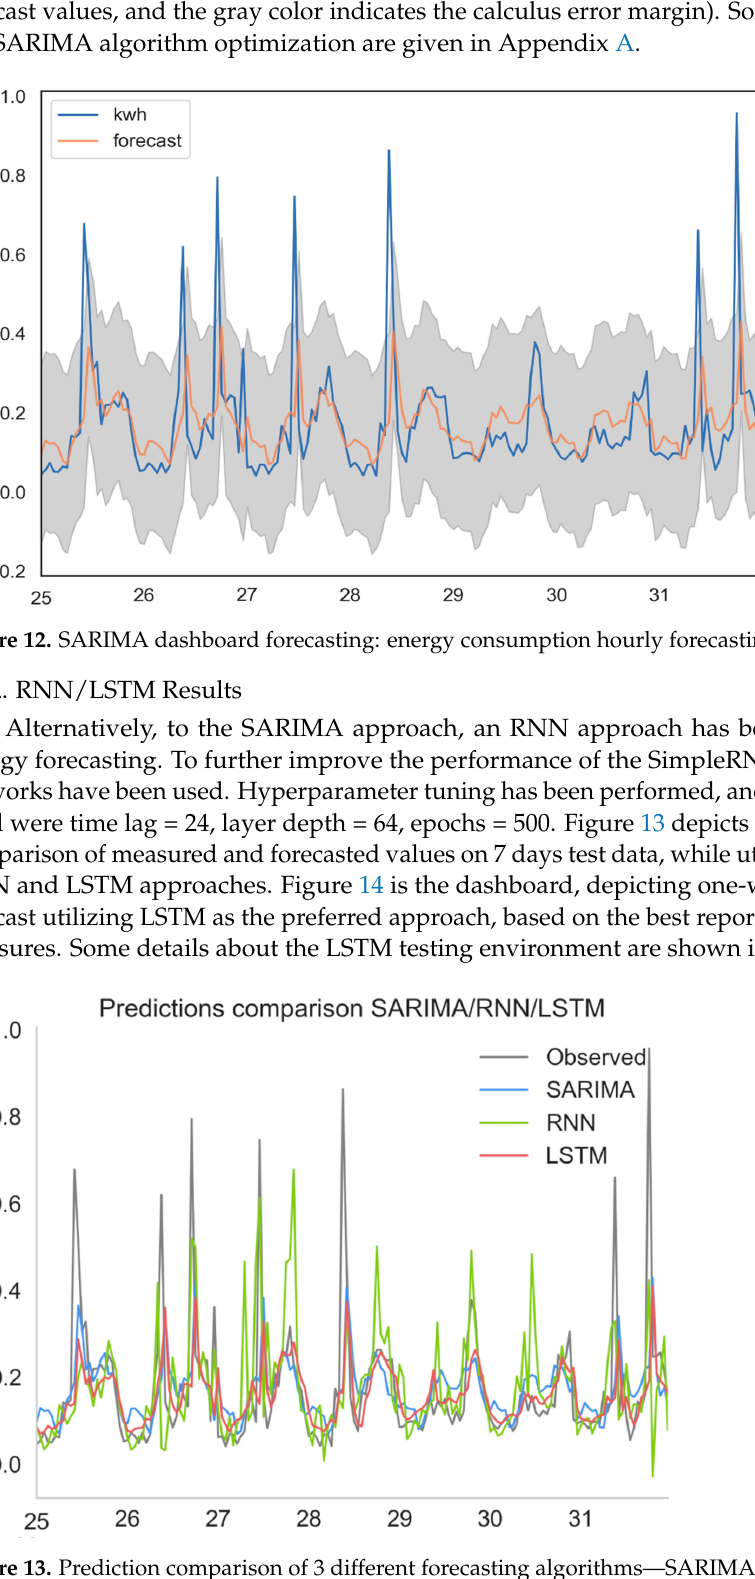
Figure 11. Average weekly energy distribution by days of week. ( a ) Percentage ‐ wise; ( b ) Con ‐ sumption ‐ wise.